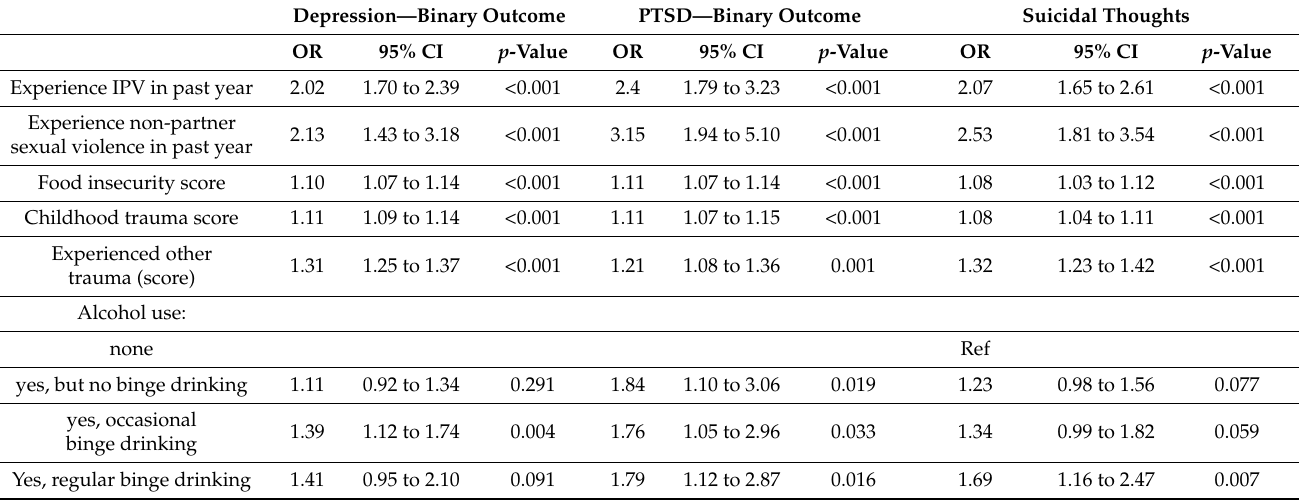
Table 4. Bivariate logistic regression of mental-ill health binary outcomes and variables. Depression—Binary Outcome PTSD—Binary Outcome Suicidal